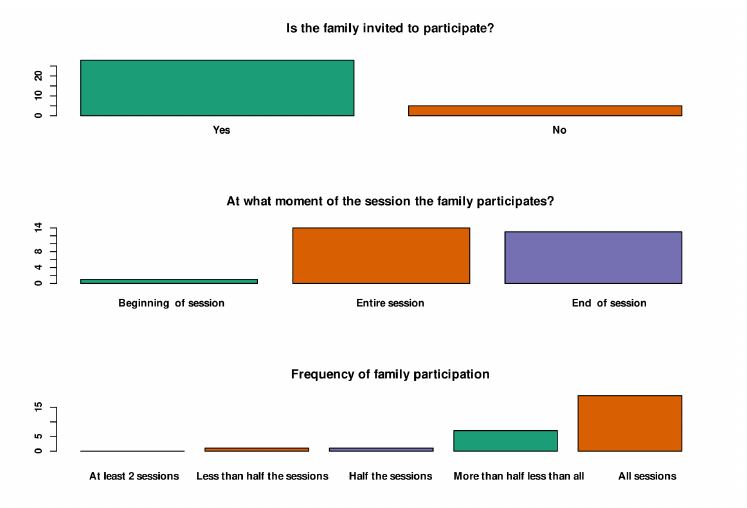
Figure 8. The story of family involvement in the therapy